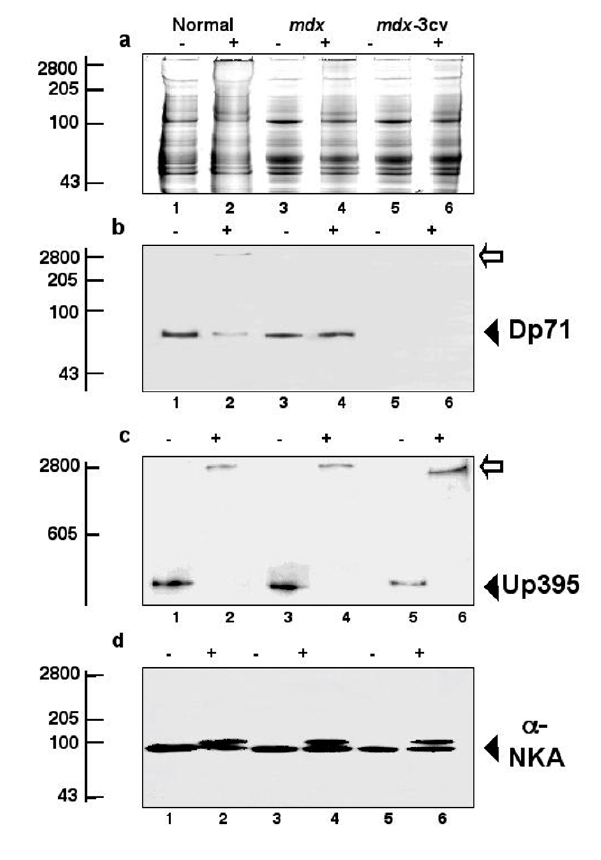
Figure 8 Chemical crosslinking analysis of brain dystrophin isoform Dp71 in normal and mdx mice. Shown is a Coomassie-stained gel (a) and identical immunoblots labeled with antibodies to the dystrophin isoform of apparent 71 kDa (Dp71) (b), full-length utrophin of apparent 395 kDa (Up395) (c), and the α -subunit of the Na + /K + -ATPase ( α - NKA) (d). Lanes 1, 3 and 5 represent untreated control sam- ples (-) and lanes 2, 4 and 6 are membranes treated with 200 µ g crosslinker BS 3 per mg protein (+). Lanes 1 and 2, 3 and 4, and 5 and 6 represent microsomal membranes isolated from normal brain, mdx brain, and mdx -3cv brain, respectively. The position of immuno-decorated monomers is indicated by closed arrow heads and crosslinking-stabilized high-molecu- lar-mass complexes marked by open arrows. The relative position of molecular mass standards ( × 10 -3 ) is indicated on the